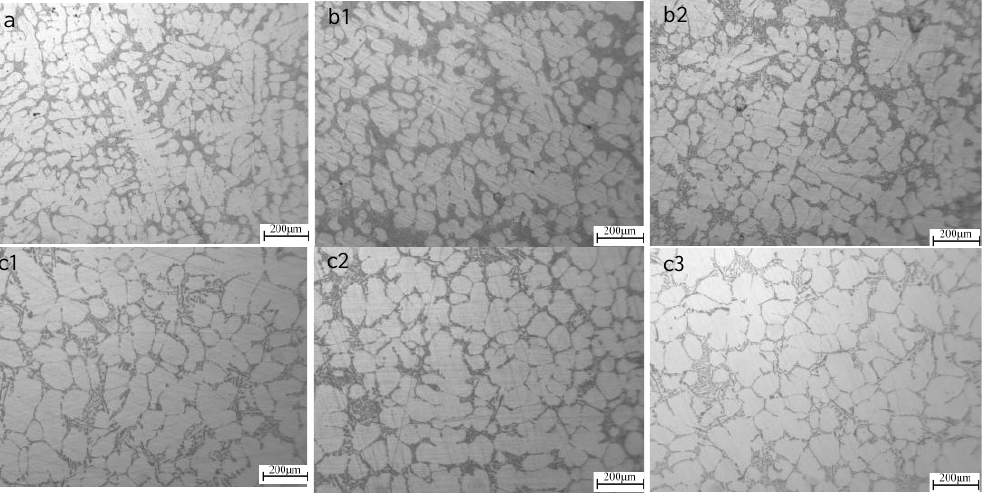
Figure 7. Semi-solid microstructure of A356 alloy under different stirring conditions: ( a ) No stir- ring; ( b1 ) rotation 300 r/min; ( b2 ): rotation 500 r/min; ( c1 ): rotation 300 r/min revolution 0.7 rad/s; ( c2 ): rotation 500 r/min revolution 0.7 rad/s; ( c3 ): rotation 300 r/min revolution 1.4 rad/s.